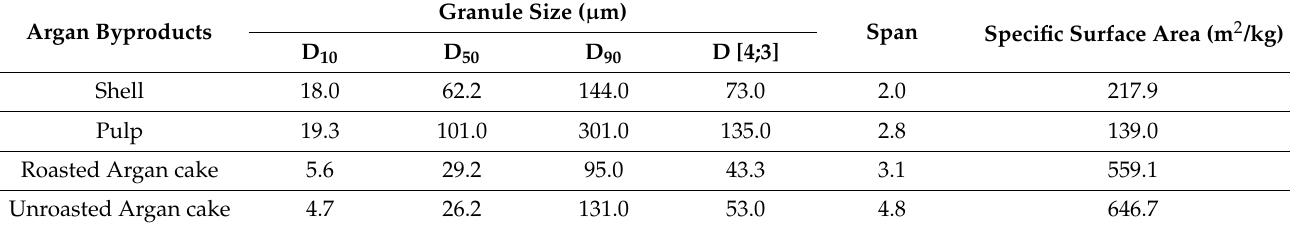
Figure 4. Particle size distribution of argan byproduct granules. Table 2. Distribution of argan byproduct granules.